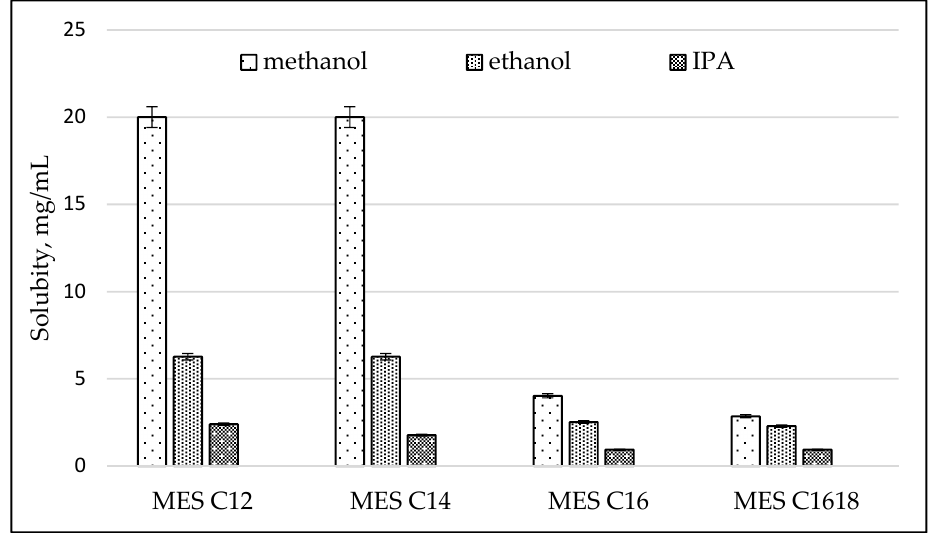
Figure 3. Solubility of MES in solvents.